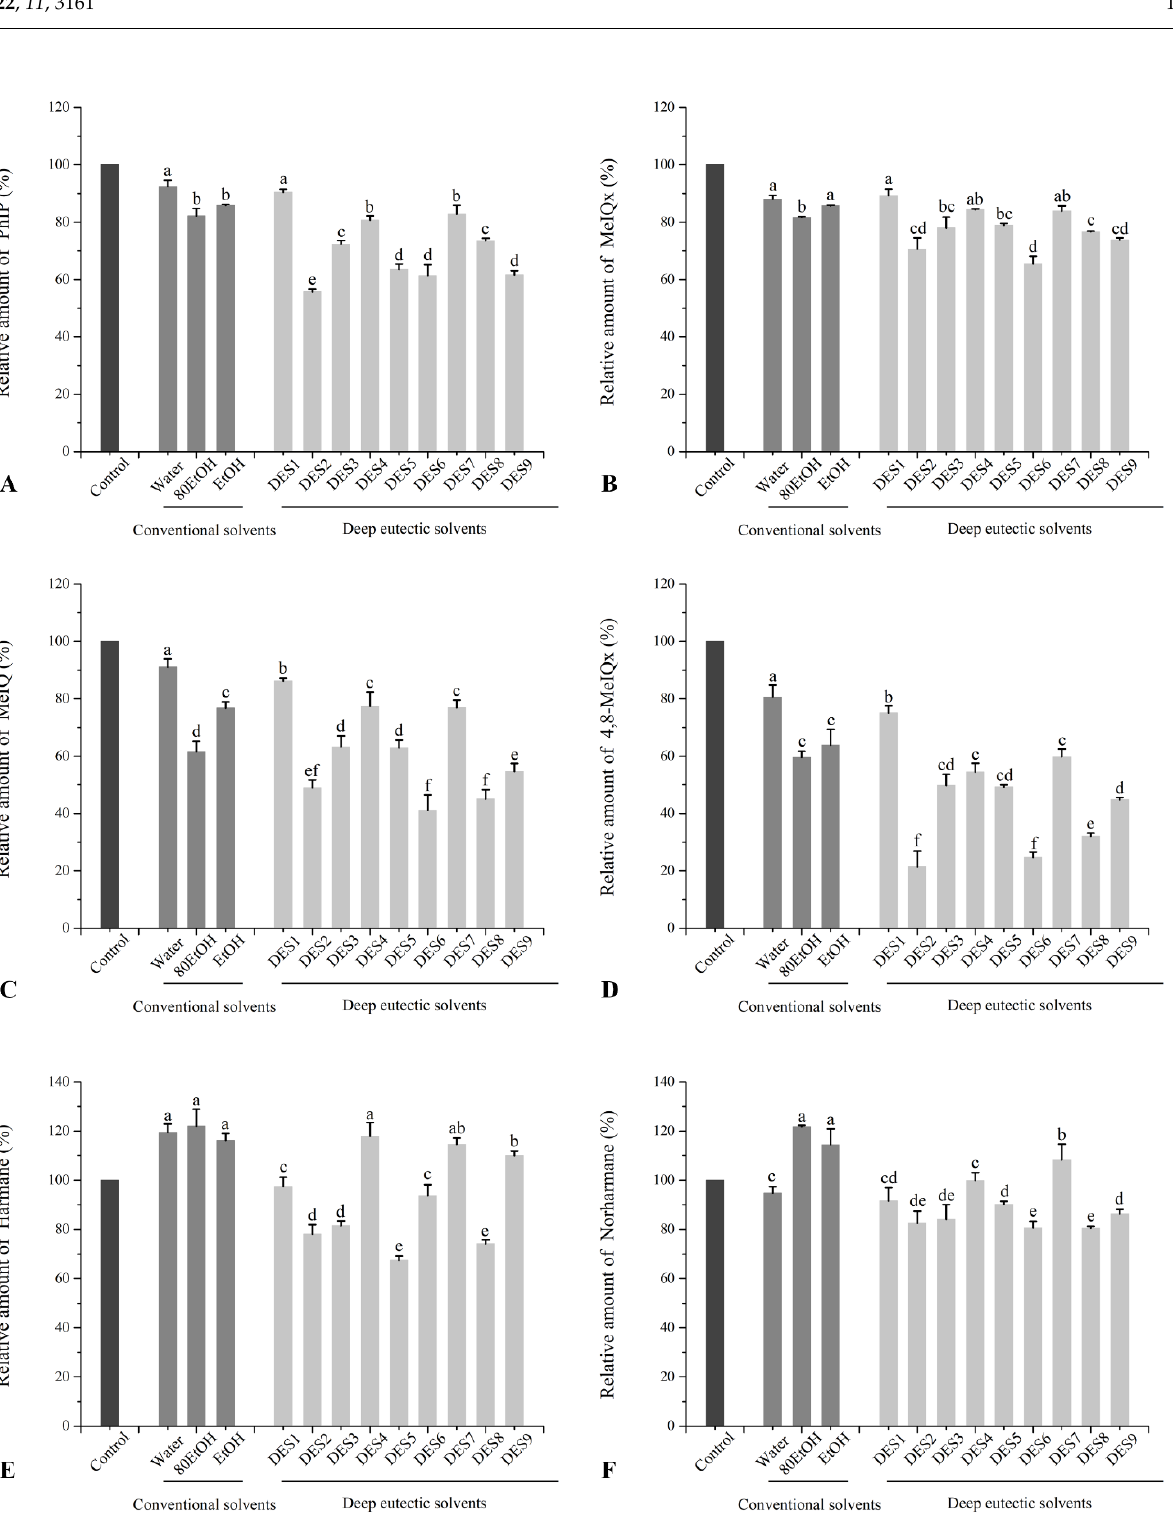
Figure 3. Relative amounts of ( A ) PhIP, ( B ) MeIQx, ( C ) MeIQ, ( D ) 4,8-DiMeIQx, ( E ) Harmane, and ( F ) Norharmane in roasted beef patties with different ginger extracts. The corresponding solvents’ abbreviations can be consulted in Table 1. Values are expressed as mean ± SD ( n = 3). Different letters in each series indicate significant differences ( p < 0.05); lowercase letters denote significant differences ( p < 0.05) between solvents.